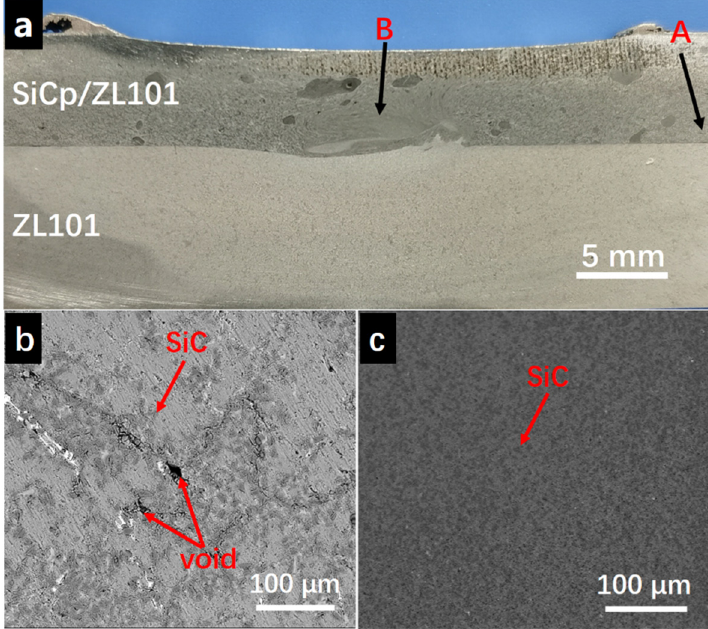
Figure 11. ( a ) Schematic diagram of the cross-section of FSLW joint; ( b ) SEM photograph of the as-cast composite material area at point A not affected by FSP in Figure 11a; ( c ) SEM photo of the nugget area at point B in Figure 11a.